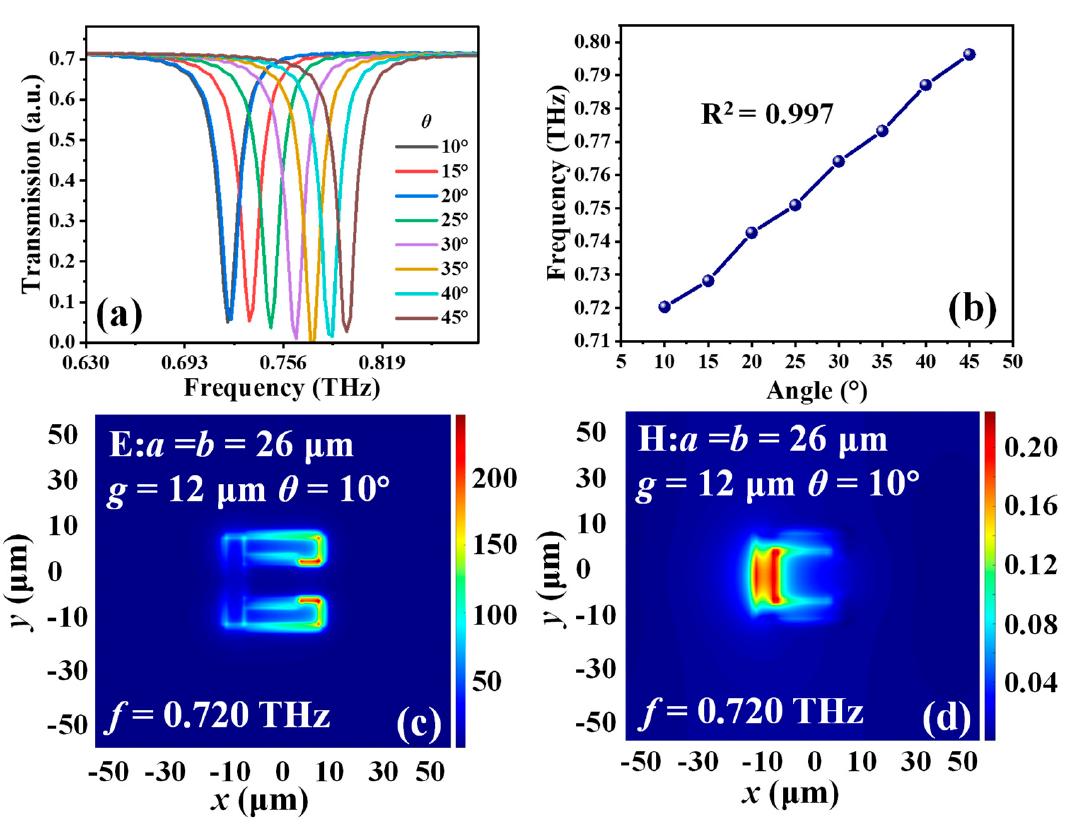
Figure 5. ( a ) Transmission spectra of MTM with different θ values. ( b ) Relationship of θ values and resonances. ( c ) E– and ( d ) H–field distributions of MTM with a = b = 26 μ m, and θ = 10° in TM mode.